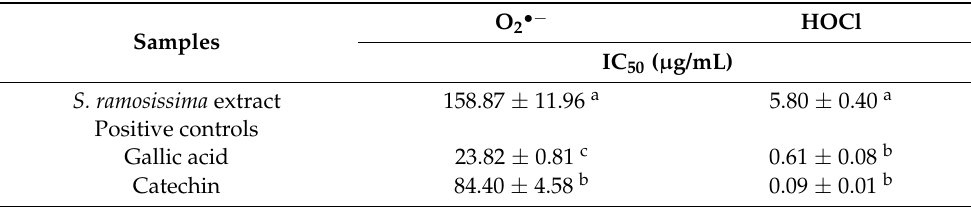
Table 3. Superoxide anion radical (O 2 •− ) and hypochlorous acid (HOCl) scavenging capacities of the best S. ramosissima extract. Values are expressed as mean ± standard error of the mean ( n = 3). Different letters in the same column indicate significant differences ( p <